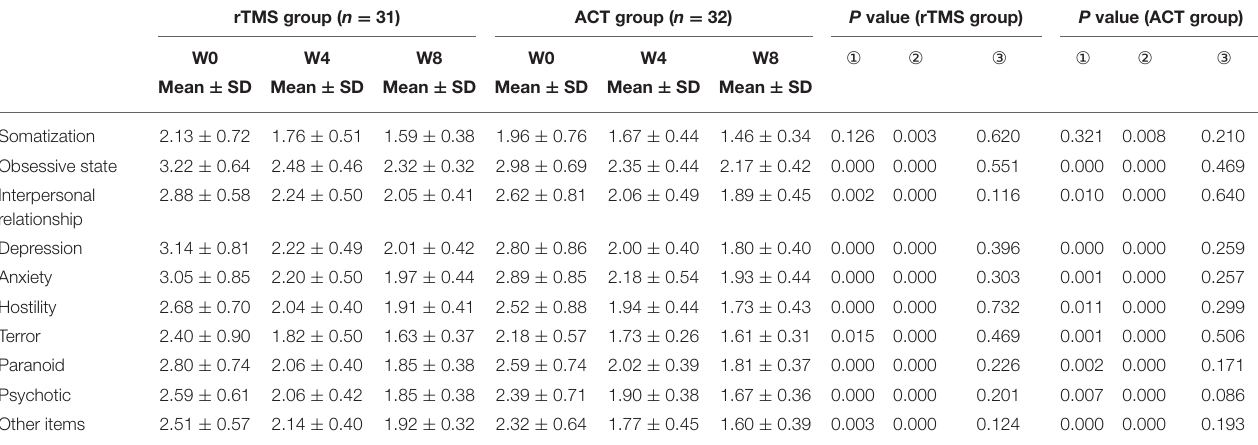
TABLE 4 | Comparison of SCL-90 symptom evaluation at different stages in the two group. rTMS group ( n = 31) ACT group ( n =